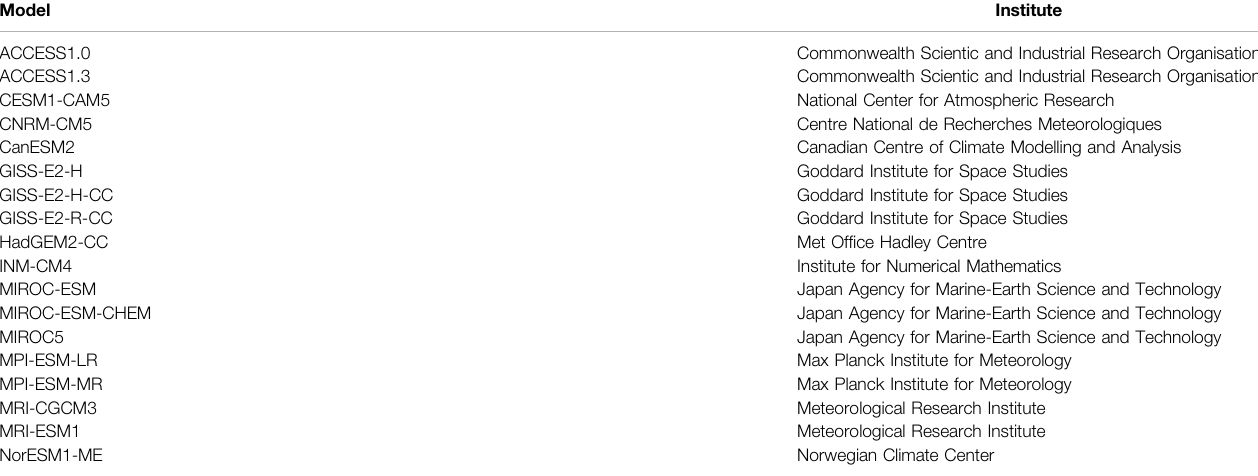
TABLE 2 | Output is used from the following models from phase fi ve of the Coupled Model Intercomparison Project. Model ACCESS1.0